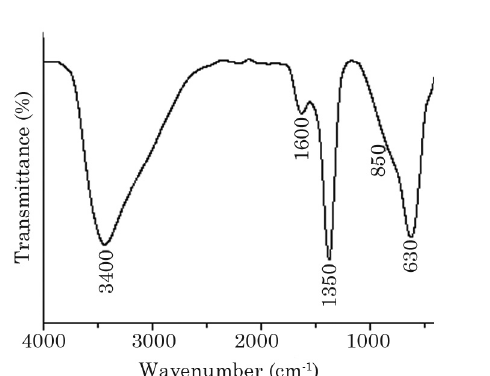
Figure 4. FTIR spectrum of a MgAl-CO 3 -LDH. Source: Tronto (non-published